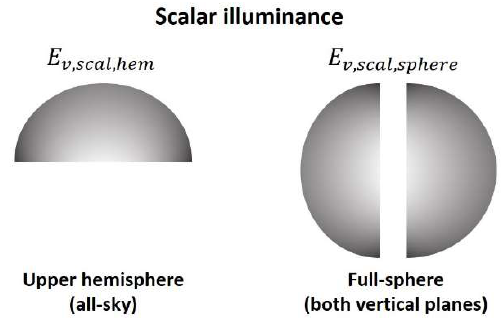
Figure 2. Illustration of hemispherical scalar illuminance obtained from an all-sky image and the total spherical scalar illuminance obtained from two images in the vertical plane.